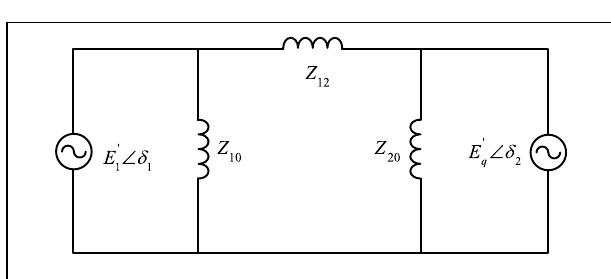
FIGURE 13 | Equivalent circuit of the active support VSC two-machine system after